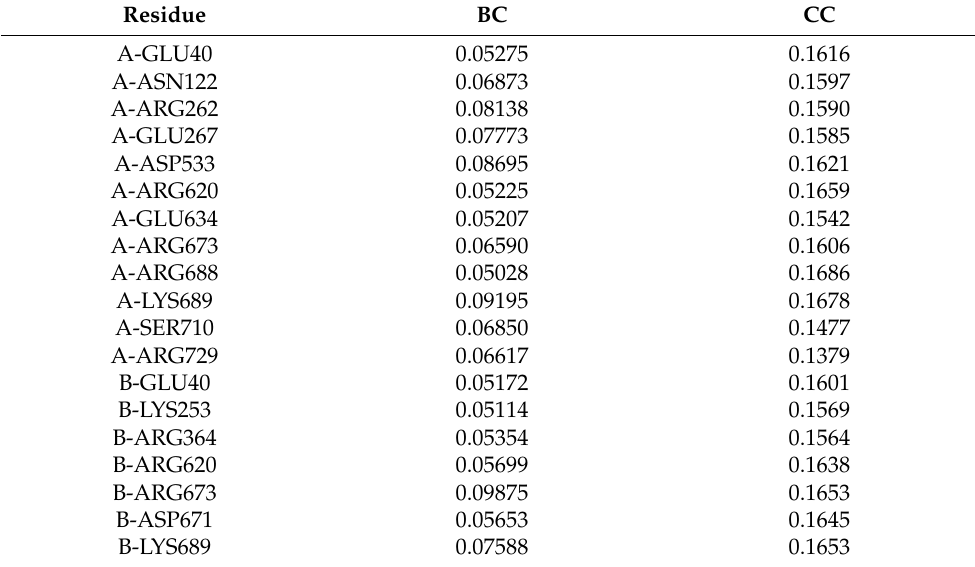
Table 2. Residues with ≥ 0.05 BC and ≥ 0.13 CC for covalent and noncovalent interactions.